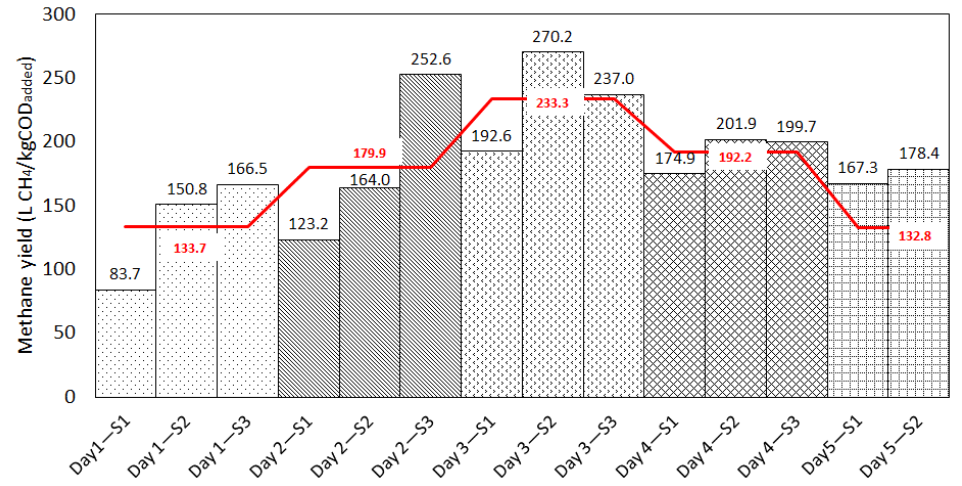
Figure 2. Methane yields obtained during anaerobic digestion of mean daily samples of rendering plant wastewater. Mean values per day in red line